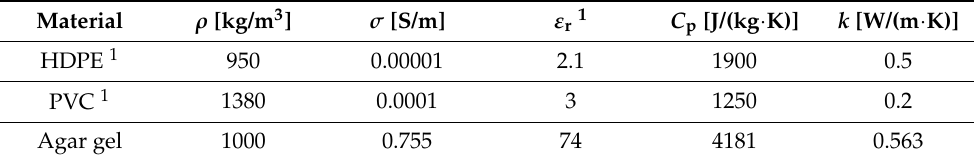
Table 1. Electrical and thermal properties of the materials considered in the